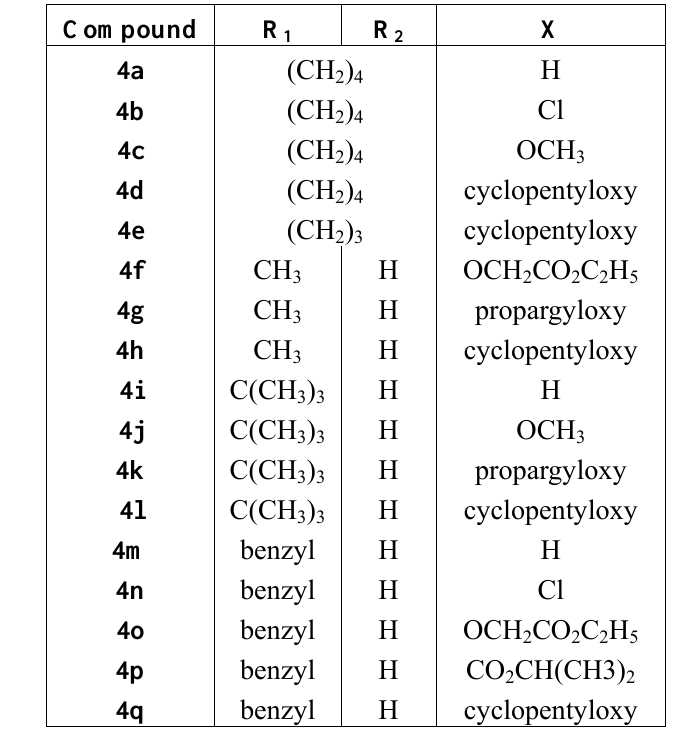
Table 1. Synthesized